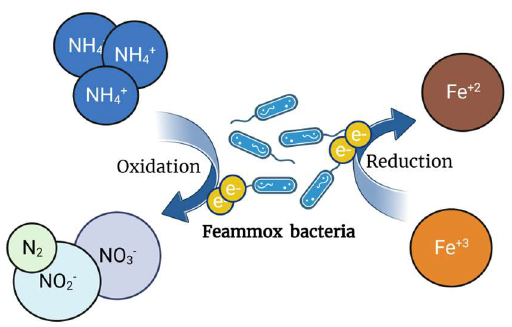
Figure 1. Illustrative diagram of the Feammox process. Created with BioRender.com (accessed on 15 December